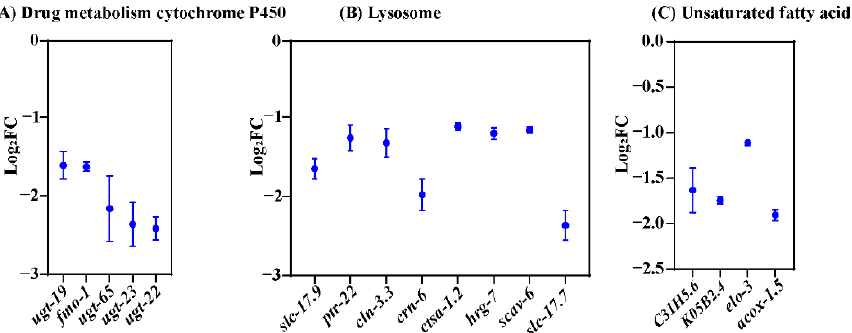
Figure 6. The expression of down-regulated pathway related genes of L. marina on CeMM. ( A ) Drug metabolism-cytochrome P450 pathway-related genes in L. marina . ( B ) Lysosome-related genes in L. marina . ( C ) Biosynthesis of unsaturated fatty acid-related genes in L. marina . Log2FC: Log2(Fold Change). All data shown here are mean ± SEM.